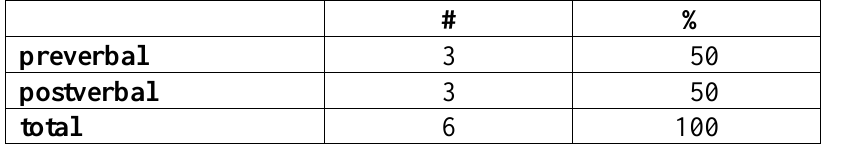
Table (7): Positioning of usted in direct non-cleft non-argumental wh